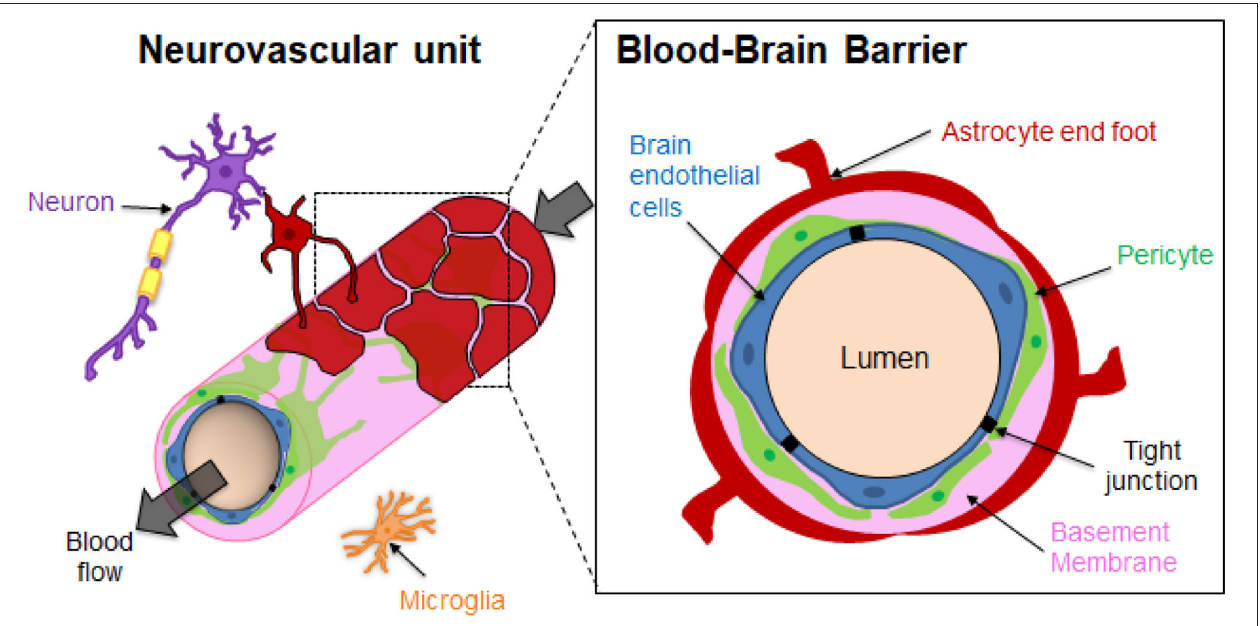
FIGURE 1 | Structural organization of the Neurovascular unit (NVU) and the Blood-Brain Barrier (BBB). The neurovascular unit (NVU) is a structural and functional complex comprising cellular and extracellular matrix components. The NVU include neurons, microglial cells, and the BBB endothelial cells (ECs), pericytes (PCs) and astrocytes (ACs). The components of the NVU interact with each other in a synergistically manner to regulate exchanges between the blood vessels and the brain.